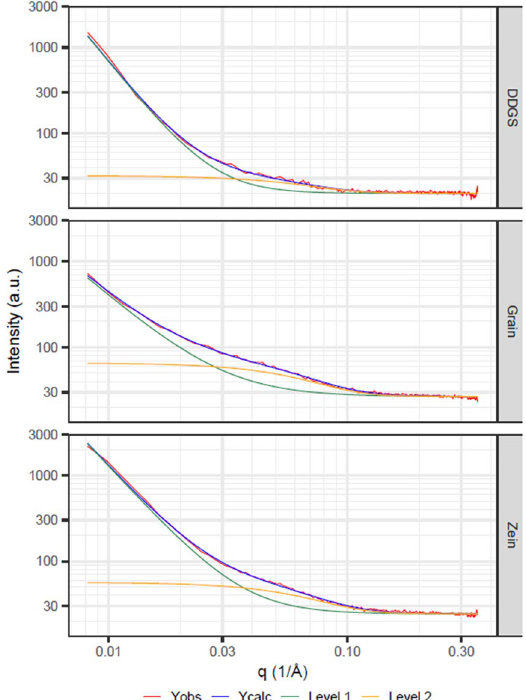
Figure 4. Small angle X-ray scattering (SAXS) patterns, showing the overall model and two individual unified- fit levels for zein, grain kafirin, and kafirin from sorghum dried distillers grain with solubles (DDGS).